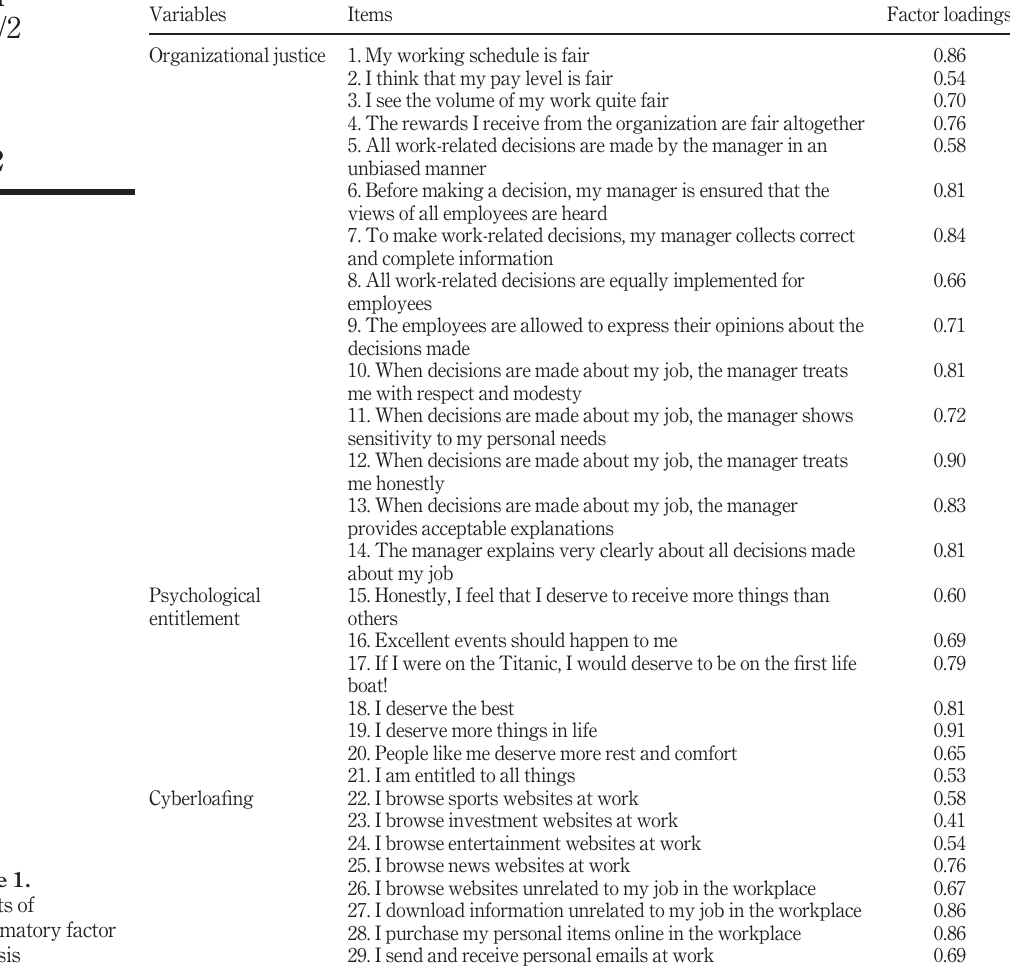
Table 1. Results of